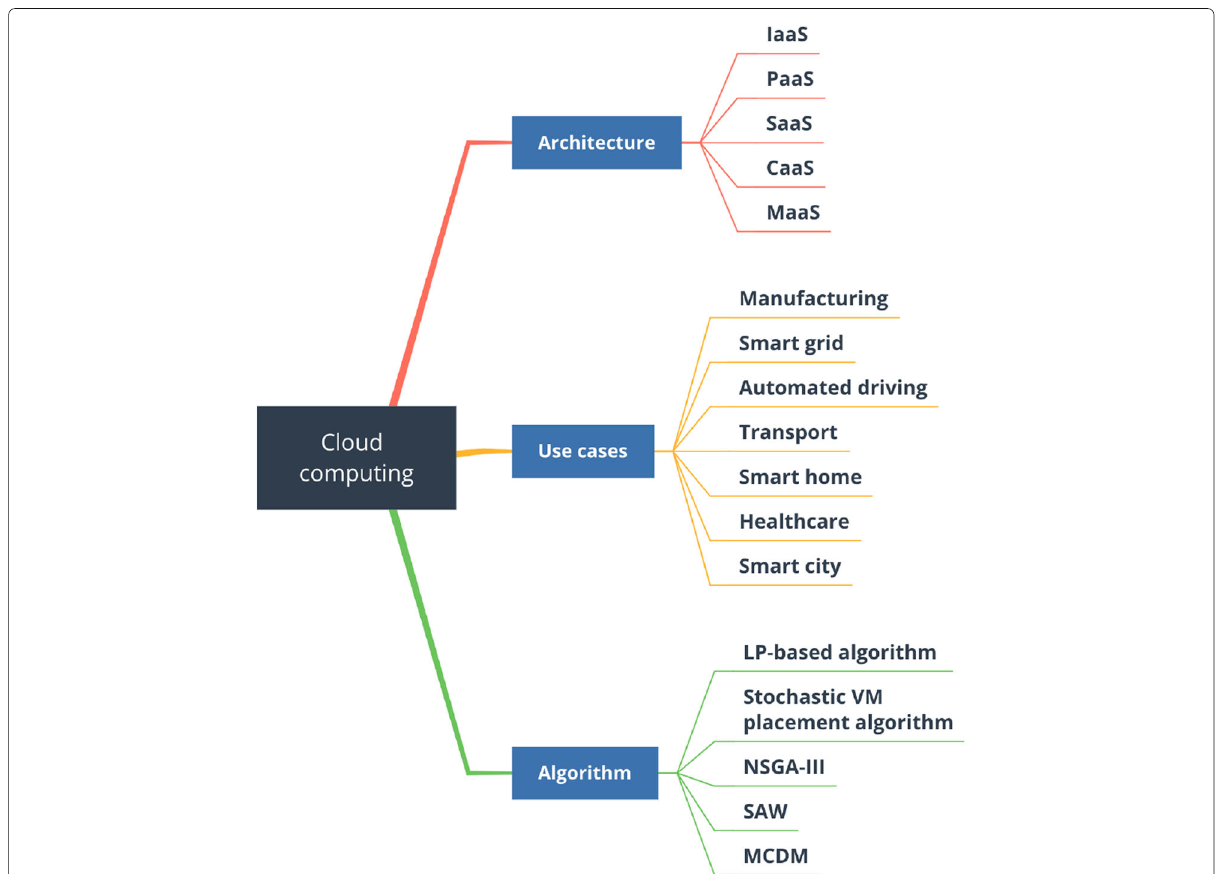
Fig. 3 A conclusion of methods adopted for CPS in cloud computing